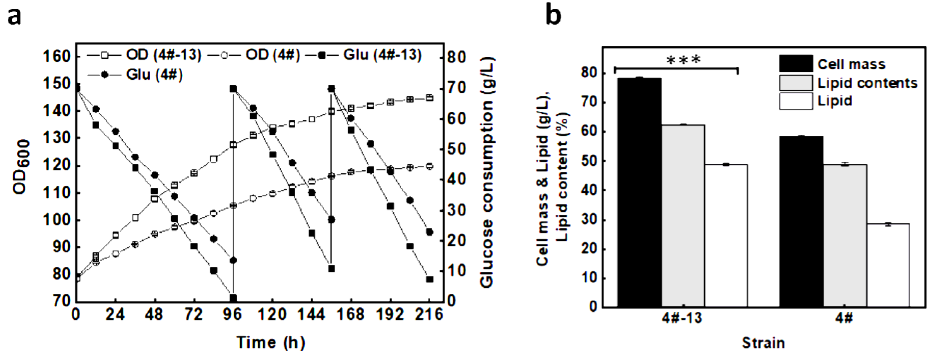
Figure 6. Lipid production on glucose solution at high cell density in 250 mL shaking flasks by R. toruloides strains. ( a ) Evolution of cell growth and residual glucose. ( b ) Results of final cell mass, lipids and lipid contents. The experiments were done with three technical replicates. Statistical significance (***, p < 0.001) was determined by one-tailed Students t -test. Data are means ± SD of three replicates.